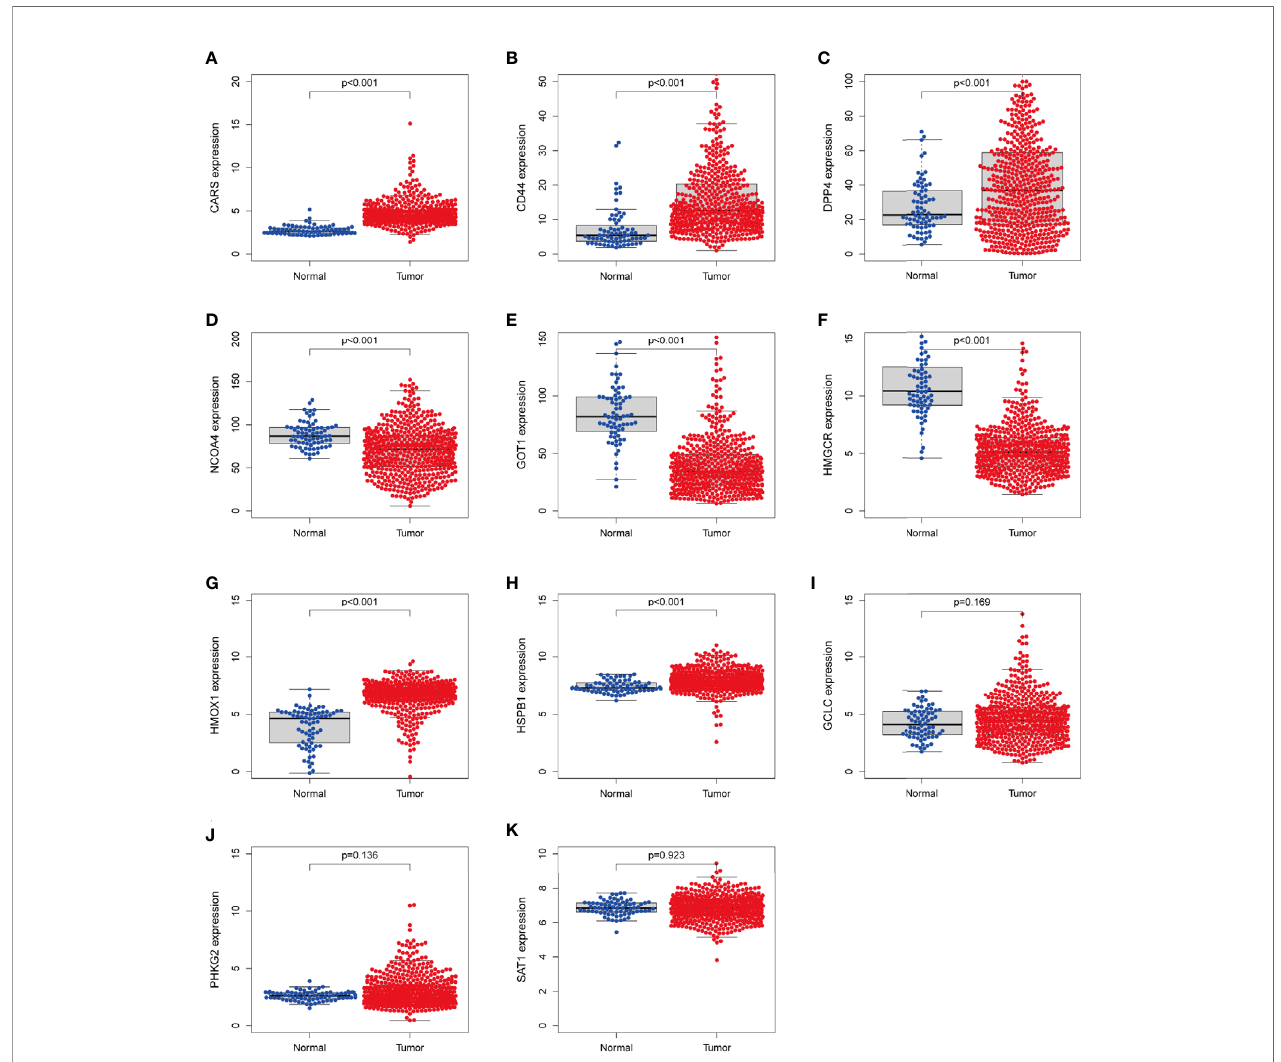
FIGURE 6 | Verify the transcriptional expression of ferroptosis-related in ccRCC and normal kidney tissues. (A) CARS, (B) CD44, (C) DPP4, (D) NCOA4, (E) GOT1, (F) HMGCR, (G) HMOX1, (H) HSPB1, (I) GCLC, (J) PHKG2, (K)